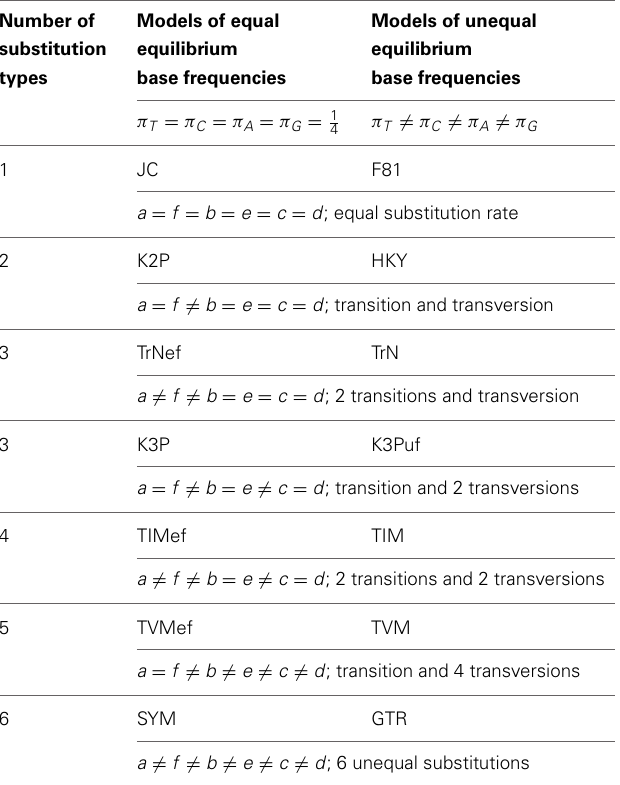
Table 1 | Parameterization of 14 nucleotide substitution models. Number of